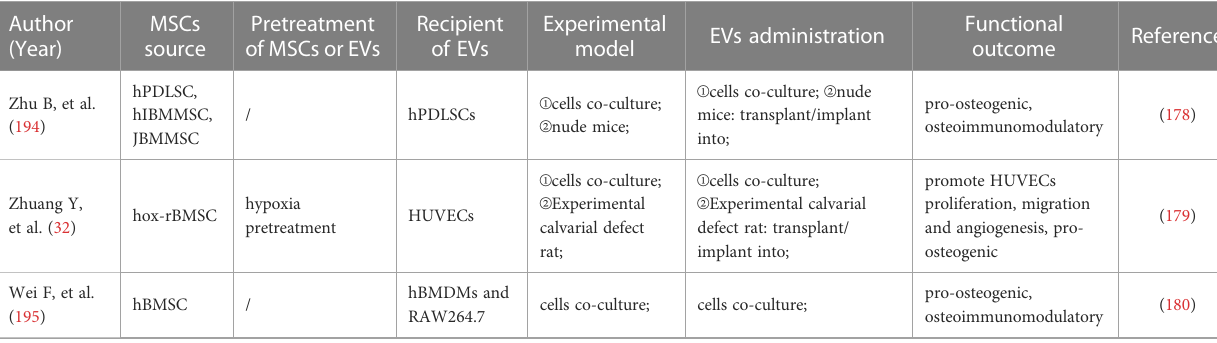
TABLE 3 Tissue regeneration of stem cell exosomes in